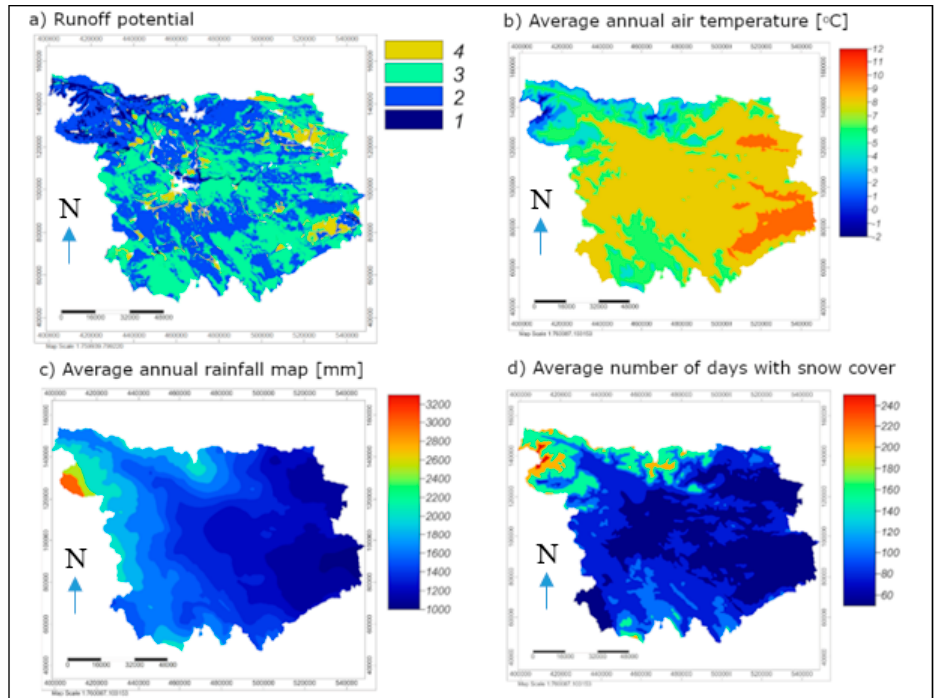
Figure 2. Runoff potential map (1 means A class, 2 B, 3 C, and 4 D class according to the Soil Conservation Service (SCS) methodology [16], average annual air temperature map, average annual rainfall map, and average number of days with snow cover map.